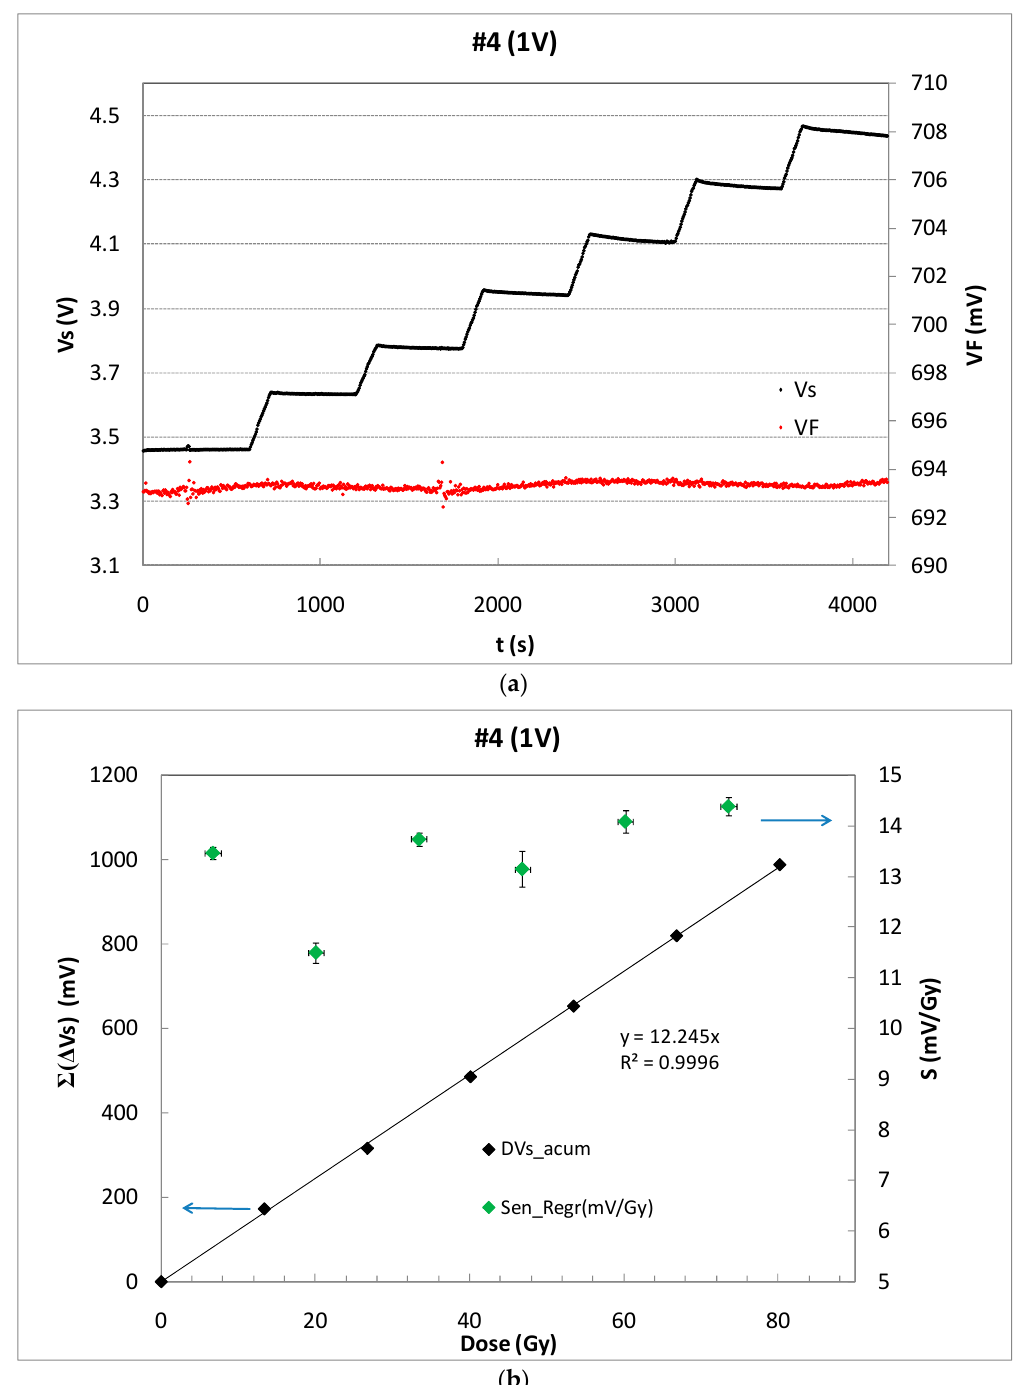
Figure 5. ( a ) Source voltage (black dots) of sample #4 biased by an external voltage of 1 V and V F in mV (grey dots), during six irradiation shoots and rest periods. ( b ) Accumulated source voltage shift as a function of the accumulated dose (empty symbols) and line showing the least squared linear fitting. The sensitivity per irradiation shot is shown by solid symbols.